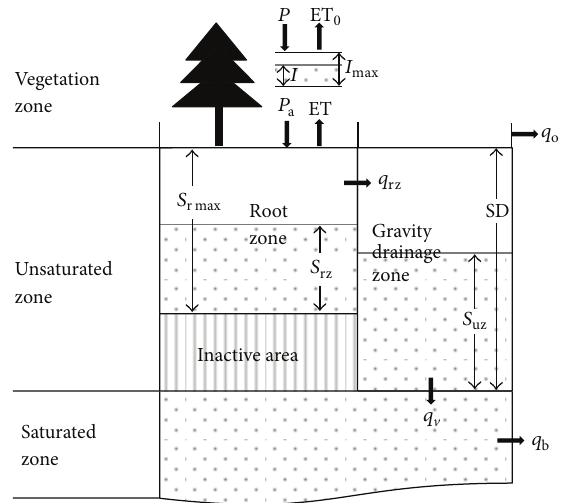
Figure 1: The river network, locations of streamflow stations and rainfall stations in Jinjiang Basin.